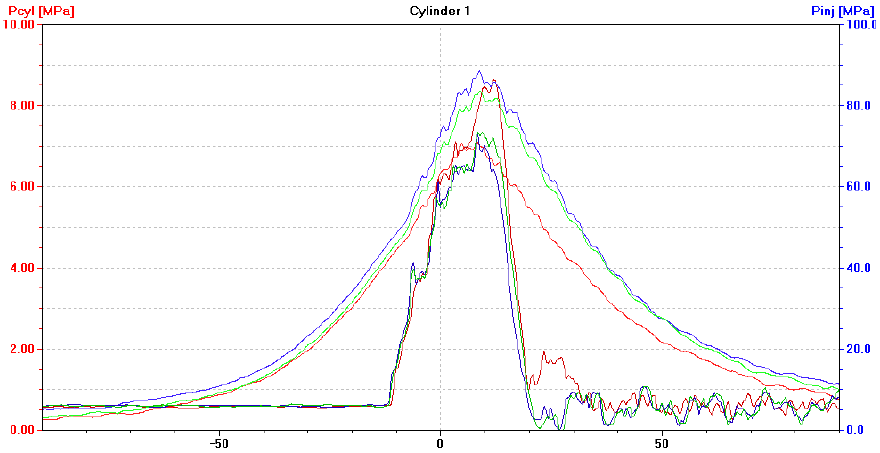
Figure 9. The diagram (screenshot of Unitest 2008) illustrates p cyl = f( α ) with the fuel injection characteristics of p inj = f( α ) for a DEU with a defective ship engine-coked injector nozzle in the first cylinder, loaded at 70% MCR. Waveforms for cylinder: — No. 1, — No. 2, — No. 3.